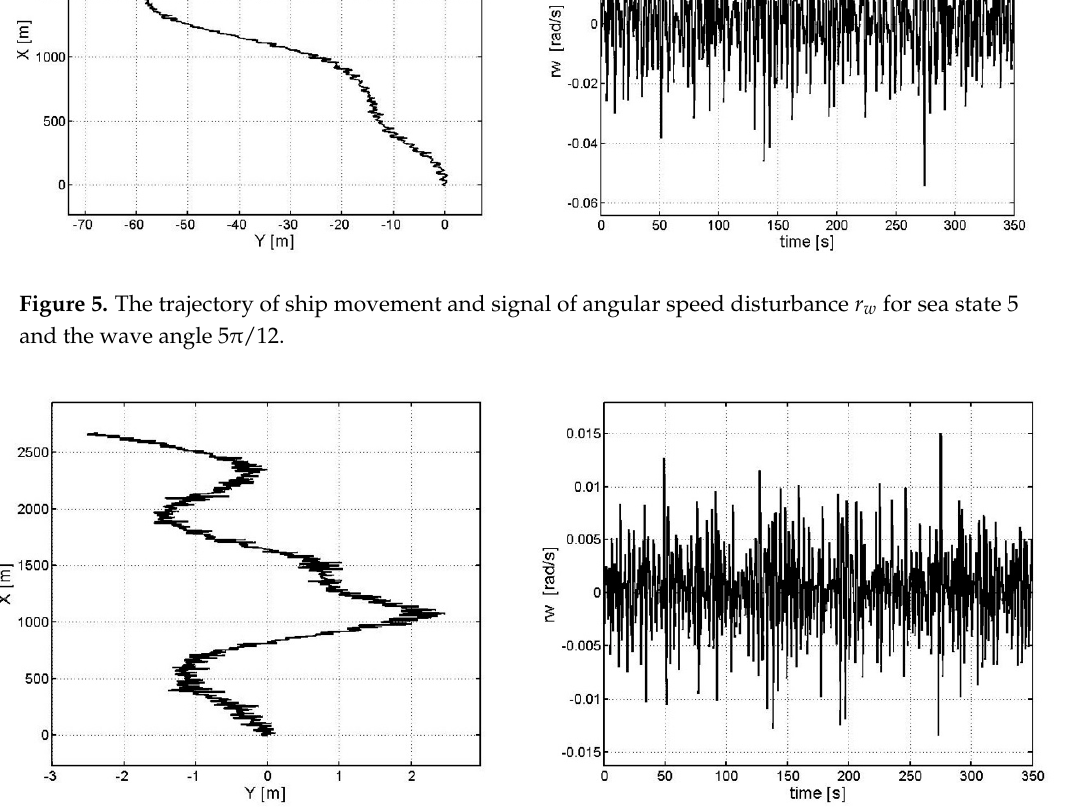
Figure 6. The trajectory of ship movement and signal of angular speed disturbance r w for sea state 5 and the wave angle 0. Algorithms 2018 , 11 , x FOR PEER REVIEW